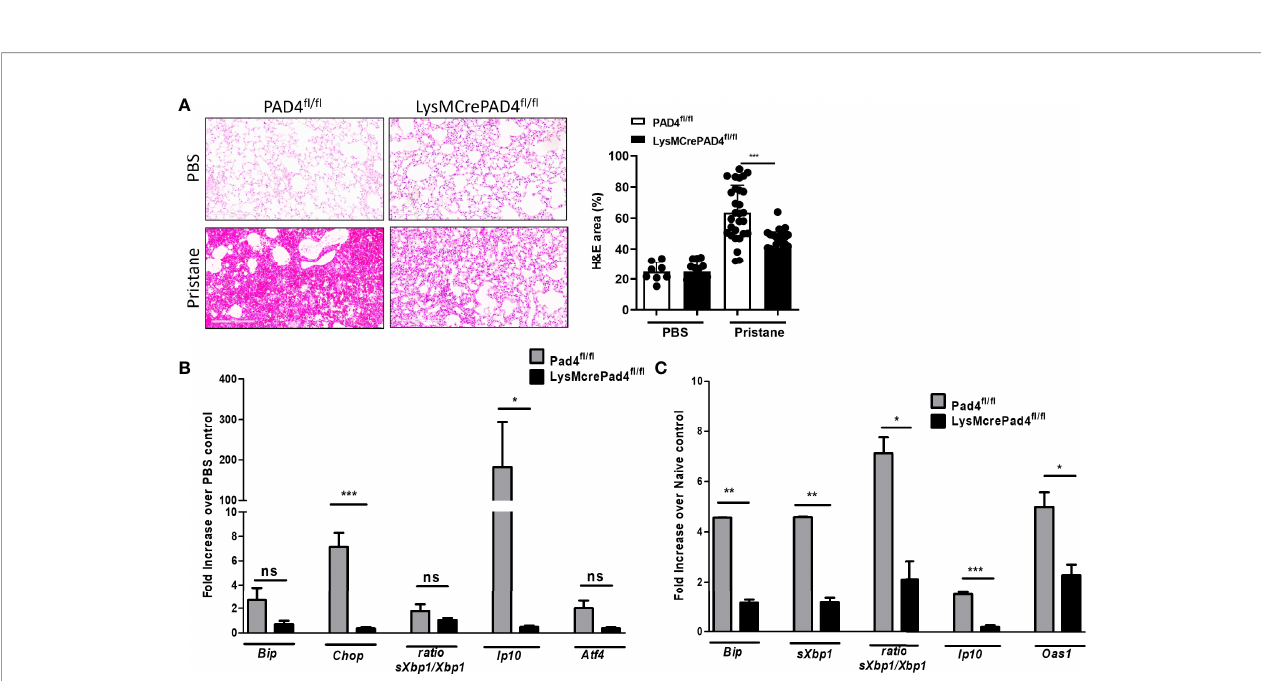
FIGURE 3 | Lung in fl ammation and ER stress genes are driven by PAD4-expressing neutrophils 7 days post pristane treatment. (A) Representative haematoxylin and eosin (H&E)-stained lung sections (x200) of PBS- or pristane-treated PAD4 fl / fl or LysMCrePAD4 fl / fl mice. Quanti fi cation of lung damage was determined from 10 randomly selected images. (B) Expression of ER stress genes and ISGs were determined by qPCR of whole lung. (C) PCLS were prepared and cocultured with neutrophils as described in Figure 2 , and PAD4 fl / fl or LysMCrePAD4 fl / fl peritoneal neutrophils were isolated after 7 days of PBS or pristane treatment. Values were normalized to neutrophils isolated from PBS-treated mice of their respective genotype. ER stress genes and ISGs were determined by qPCR of whole cells. Values are the mean ± SD. In each case data is representative of 2 individual experiments with per group. Statistical signi fi cance was determined by one-way ANOVA test. * p < 0.05, ** p < 0.01, and *** p ≤ 0.001. ns, not signi fi